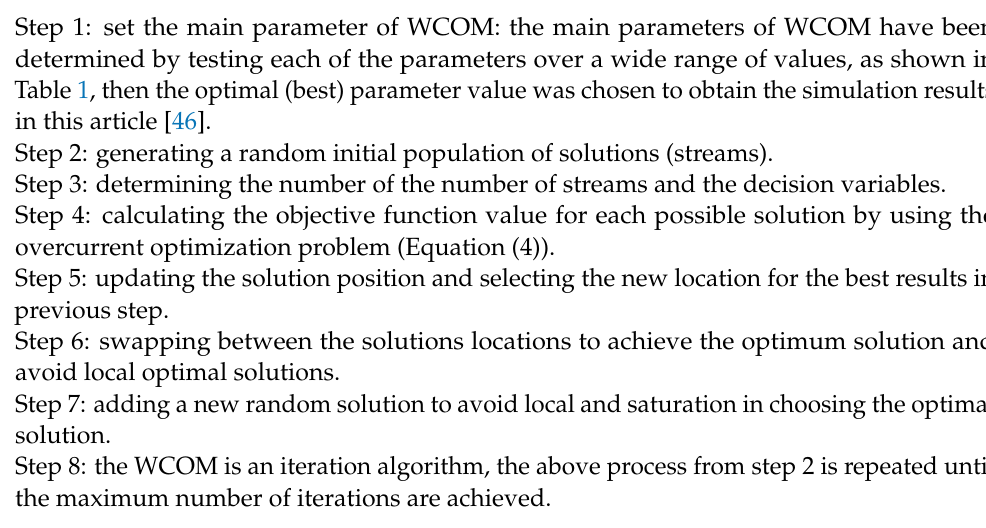
Table 1. The main parameters of the WCOM. Parameters Value The maximum number of